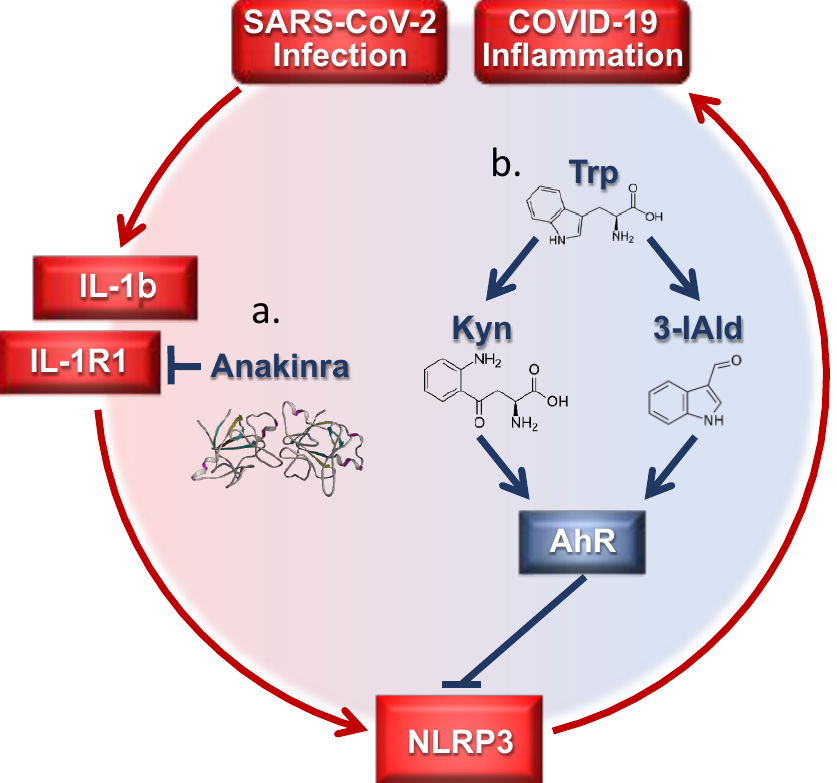
Figure 1. Targeting inflammatory pathways in coronavirus disease-19 (COVID-19) by tryptophan (trp) metabolites and Anakinra. ( a ) Anakinra inhibits NLRP3 by blocking IL-1R1 activation; ( b ) endogenous trp metabolites target AhR downregulating the NLRP3 pathway. Kyn = kynurenine; 3-IAld = Indole-3-carboxaldehyde.